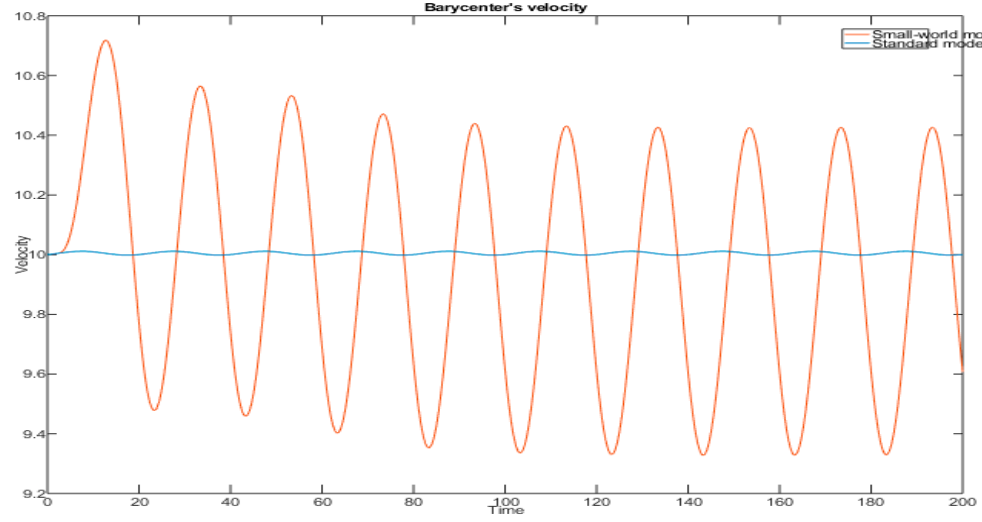
Figure 19. Comparison between the barycenter’s velocity for the standard and small-world model, for a sinusoidal perturbation of the leader Equation (14), as in Figures 9 and 11.